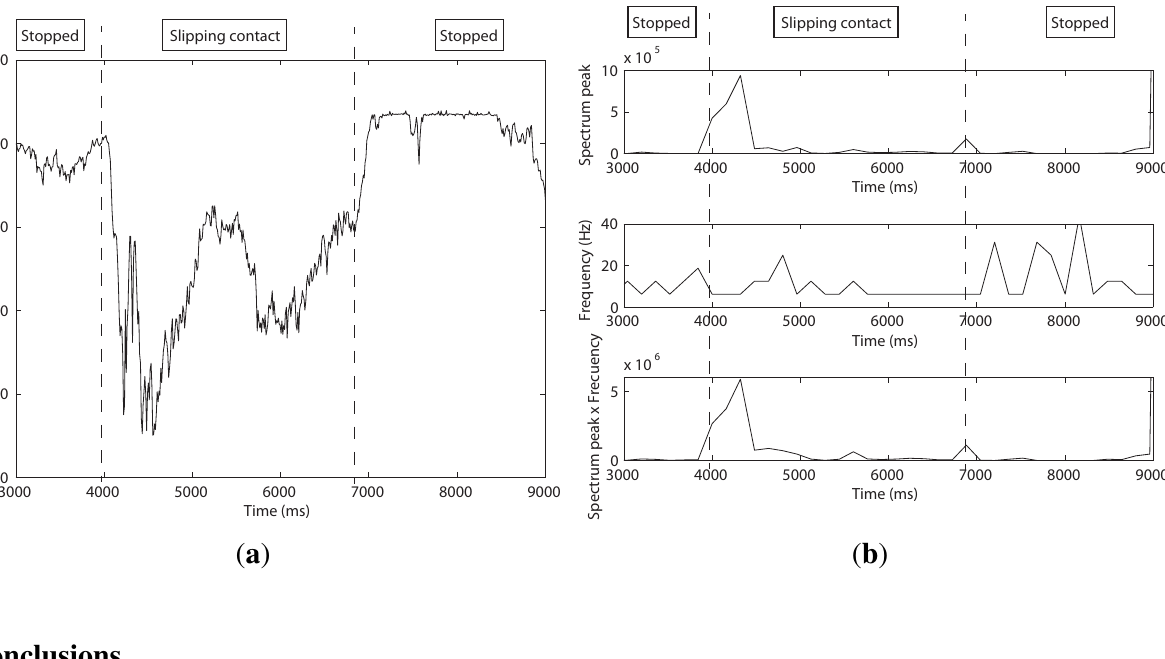
Figure 19. ( a ) The forces in the matrix sensor as a function of time; ( b ) spectrum peak and its frequency on a taxel as a function of